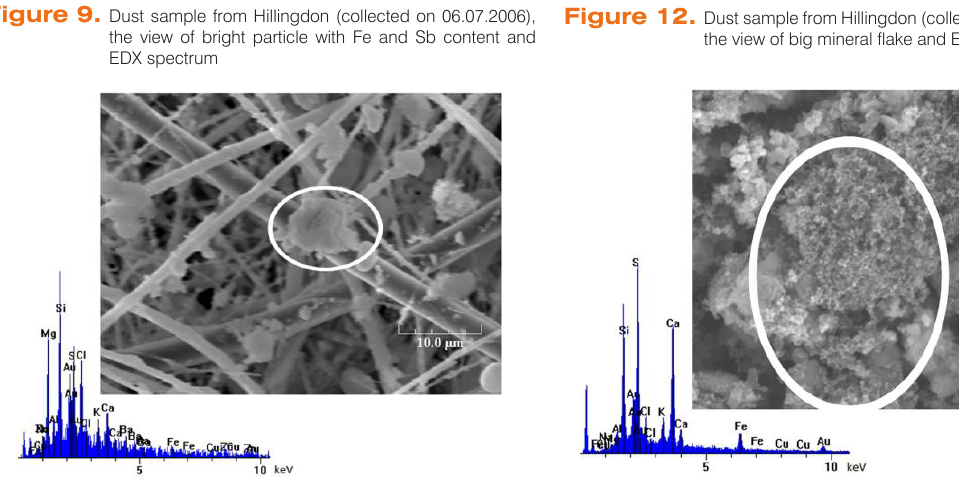
Figure 13. Dust sample from Hillingdon (collected on 28.07.2006): Figure 10. Dust sample from Gdansk (collected on 15.06.2006), the view of mineral dust (diameter 0,1 - 0,2 μm), PM the view of particle with Mg content and EDX spectrum containing great quantity of S, Ca and Si and EDX spectrum